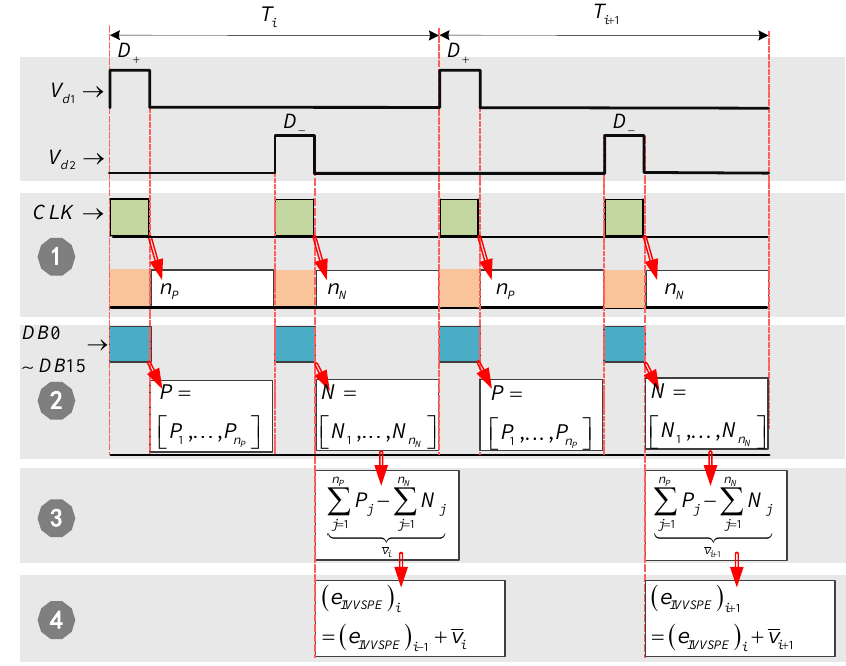
Figure 10. The structure diagram of the parallel operation for integral